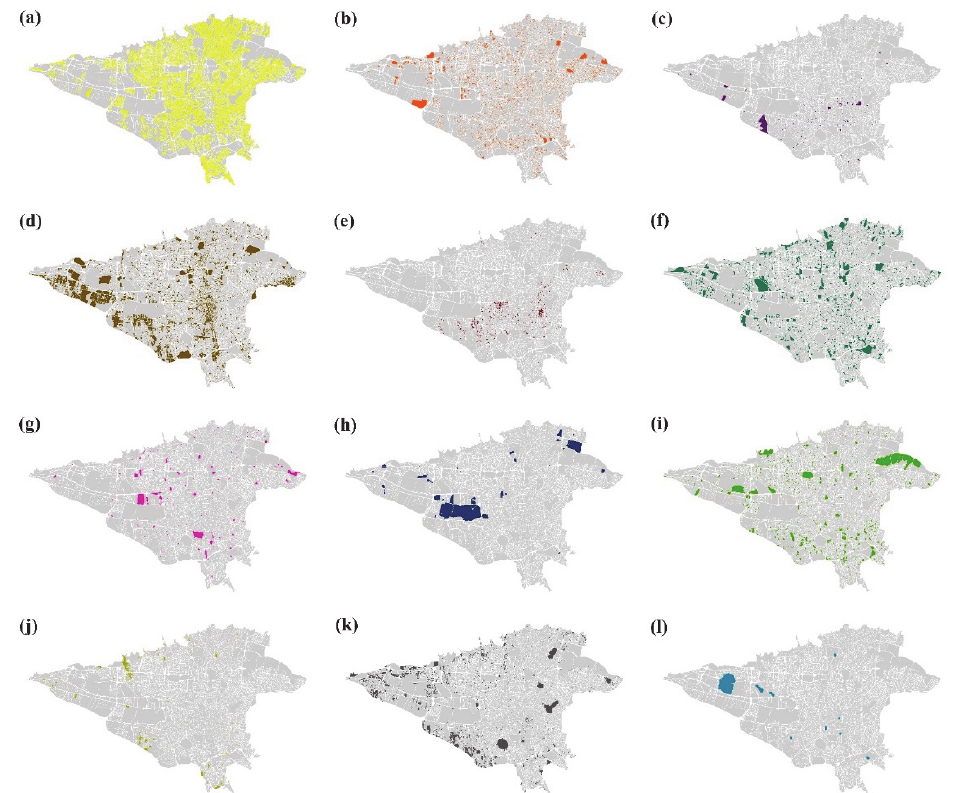
Figure 3. Spatial analysis of 12 dominant types of land use in Tehran: ( a ) residential; ( b ) residential– commercial; ( c ) commercial–urban services; ( d ) commercial–ministerial; ( e ) residential–urban services; ( f ) urban services; ( g ) urban infrastructure equipment; ( h ) martial; ( i ) green spaces; ( j ) urban agriculture; ( k ) barren; ( l ) lakes and pools.